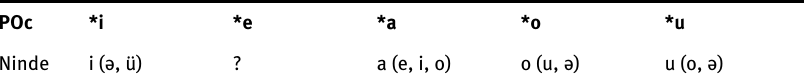
Table 4: Ninde reflexes of POc non-final vowels.